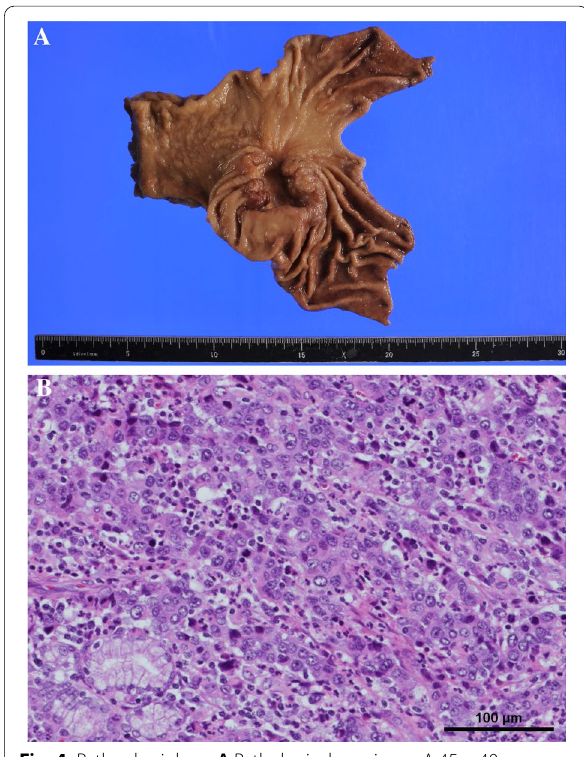
Fig. 4 Pathophysiology. A Pathological specimen. A 45 type 3 lesion was found 2.5 cm from the proximal margin and 7 cm from the distal margin. B Hematoxylin–Eosin double stain, Histologically, the lesion shows moderately to poorly differentiated